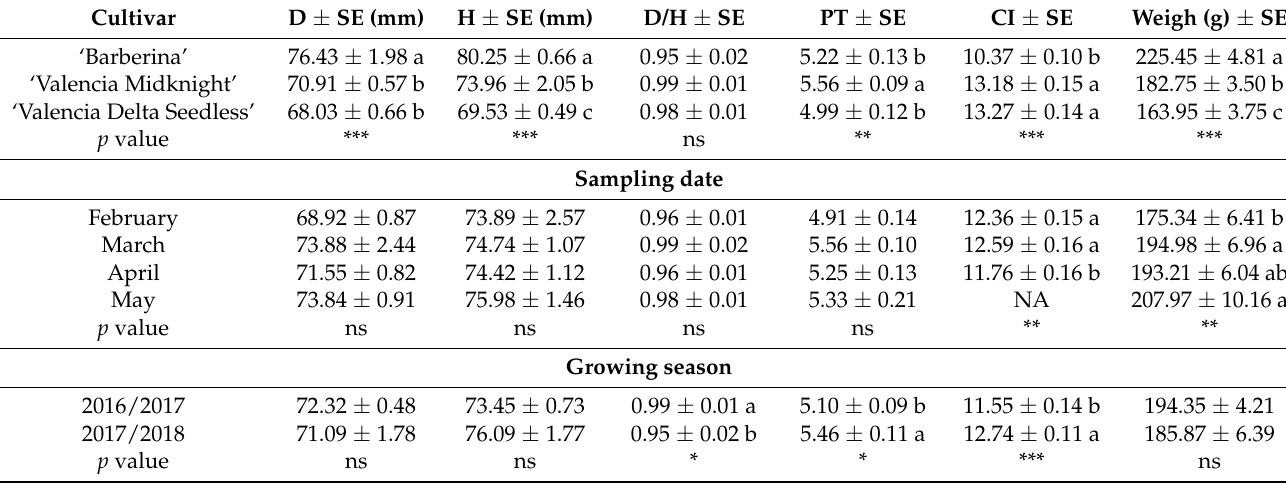
Values with different letters are significantly different among cultivars, sampling date (month) or growing season, by LSD-Fisher test ( p < 0.05). Significant level: ns = not significant; * = p < 0.05; ** = p < 0.001; *** = p < 0.0001. NA: Not available data. D: Diameter; H: